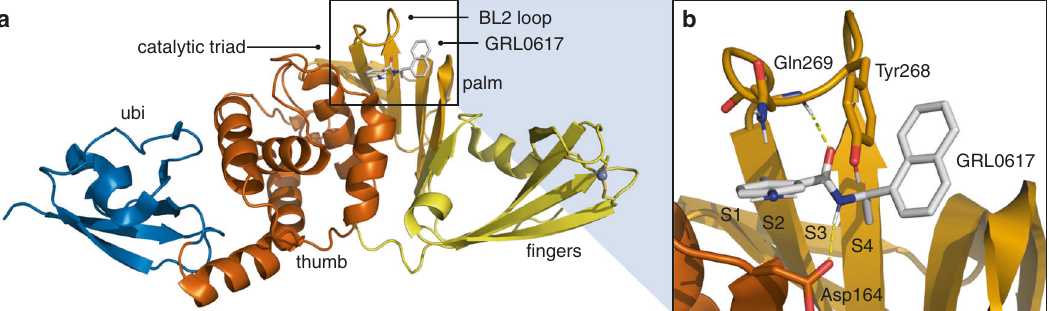
Fig.1|StructureofPLprofromSARS-CoV-2.a Overallstructure(PDBentry7JIR 14 )coloredbydomainandselectedfeatureslabeled. b InteractionsbetweenPLproandthe noncovalent inhibitor GRL0617. Selected residues and substrate binding subsites are